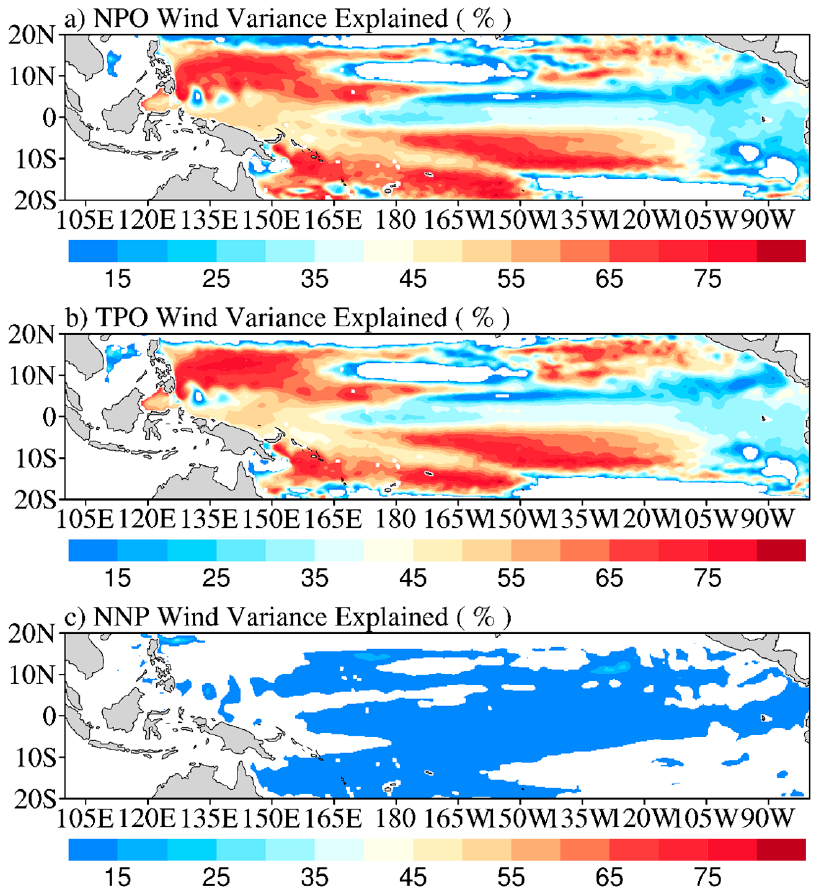
Figure 7. Contributions of different wind forcing to interannual sea level variations: ( a ) the real monthly wind field; ( b ) the real wind field in the TPO and the climatic wind field in other regions; ( c ) the real wind field in other regions and the climatic wind field in the TPO.